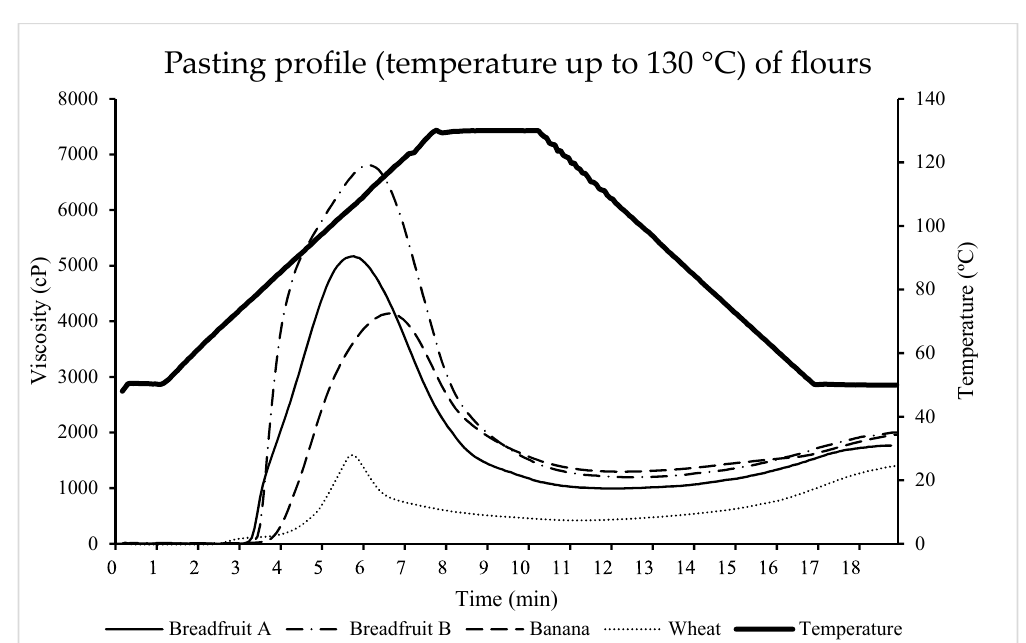
Figure 7. The pasting properties of tropical flours compared with a traditional flour using RVA method #2 (maximum temperature of 130°C). Treatments were flour types of breadfruit A, breadfruit B, banana, or wheat. Breadfruit flour A was sourced from Natural Foods International (Apia, Western Samoa). Breadfruit flour B was sourced from Jungle Project (Alajuela, Costa Rica). Banana flour was sourced from LiveKuna, Kunachia LLC (Davie, FL, USA). Wheat flour was obtained commercially from Bulk Barn Foods (Aurora, ON, Canada).